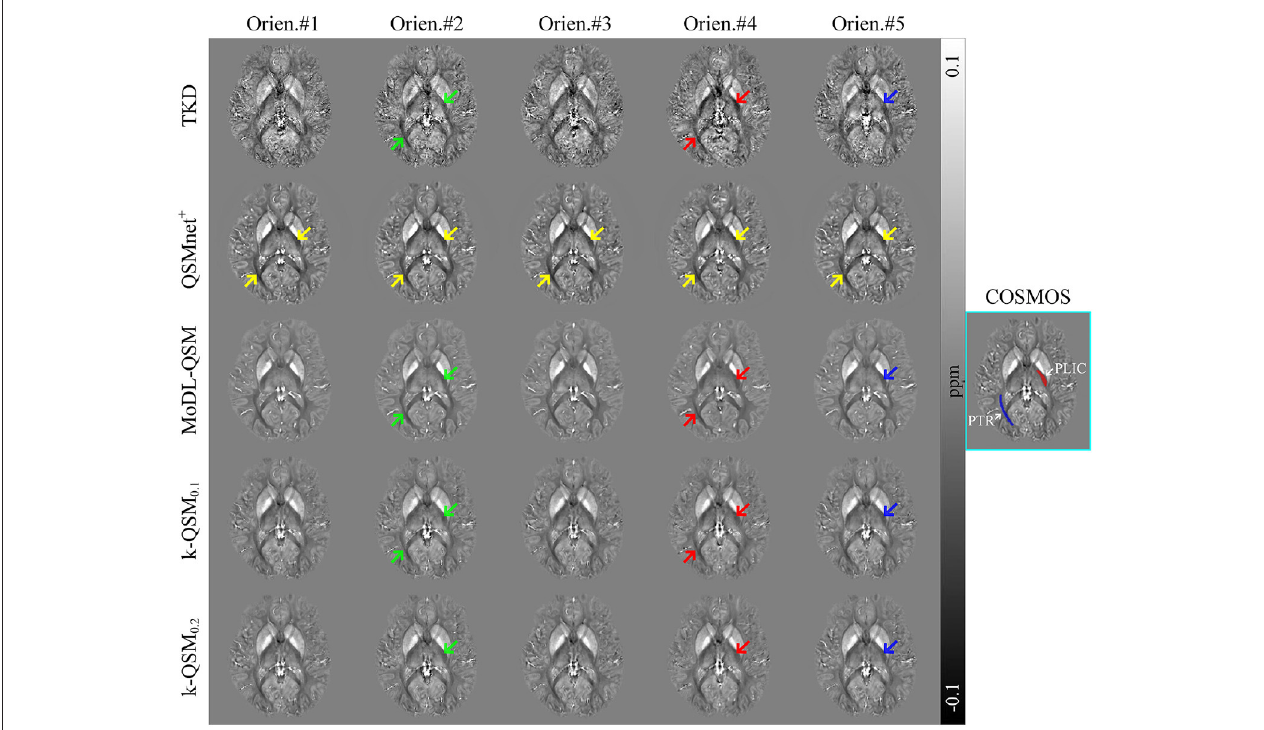
FIGURE 5 | Axial views of quantitative susceptibility mapping (QSM) reconstructed from the same subject in five head orientations. Posterior limb of the internal capsule (PLIC) (red) and posterior thalamic radiation (PTR) (blue) are marked in calculation of susceptibility through multiple orientation sampling (COSMOS). Green, red, and blue arrows indicate the susceptibility anisotropy in white matter, and yellow arrows reveal the anisotropy free regions. Truncated k-space division (TKD) truncated value is 0.2.